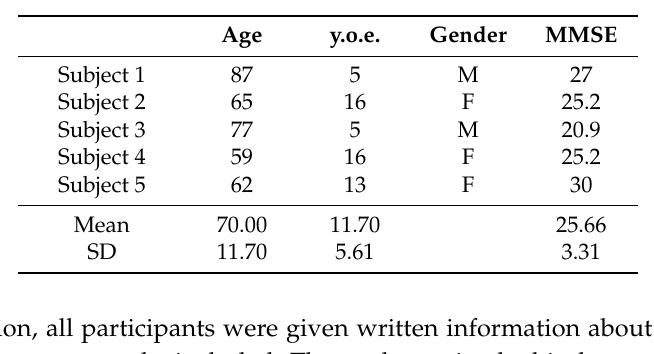
Table 2. Demographic data.